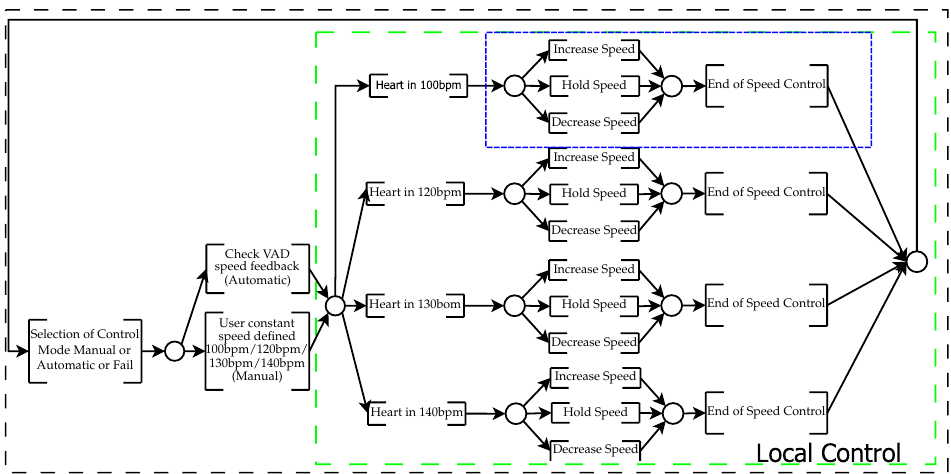
Figure 7. PFS model of the VAD Safe Supervisory control system under study. Four heart beating ranges are defined: 100, 120, 130, and 140 bpm. The module inside the blue box is detailed in Figure 8.